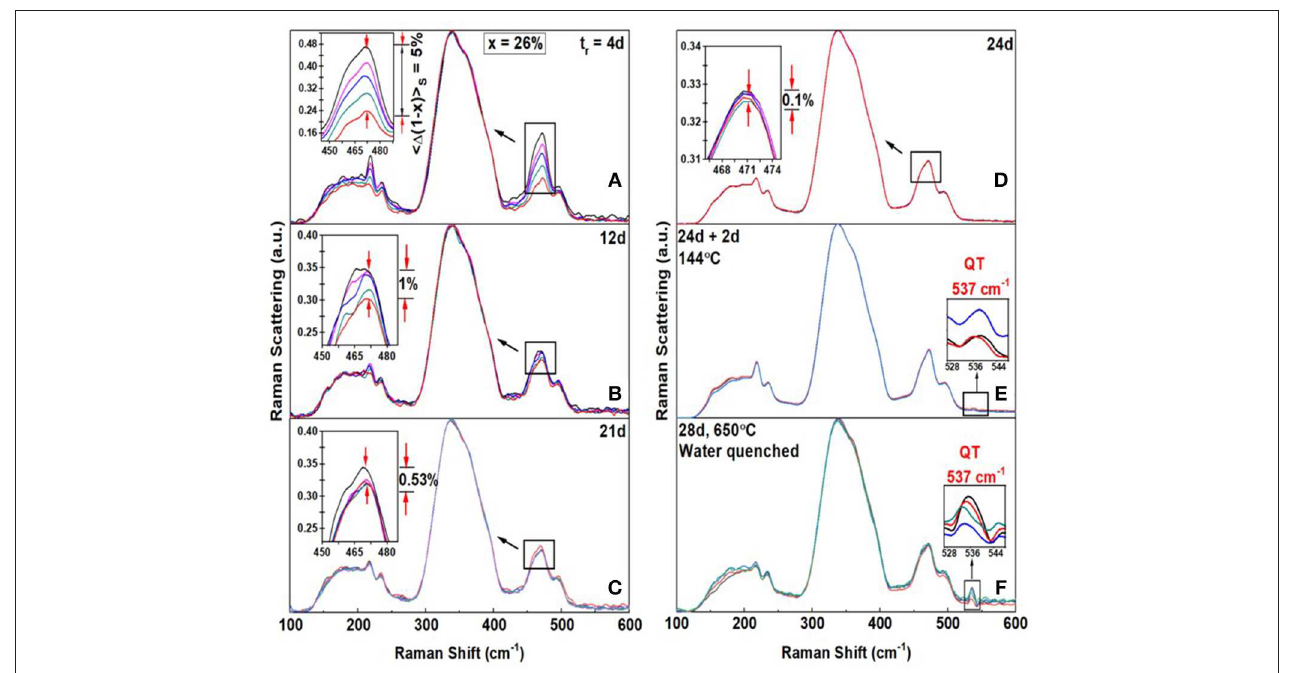
FIGURE 7 | FT—Raman profiling results of an As x S 100 − x glass at x = 26% revealing the Sulfur variance <1 (1-x) > S (A) to be 5% after alloying for t r = 4d (B) the variance ∼ 1% after t r = 12d, (C) the variance = 0.53% after 12d (D) the variance = 0.1% after t r = 24d. (E) When the glass is heated to 144 ◦ C = T g + 10 ◦ C for 2d, evidence of the 537 cm − 1 mode first appears. (F) When glass was next heated to 650 ◦ C for 2d and water quenched, the scattering strength of the 537 cm − 1 mode increased substantially. These changes in Raman lineshapes in going from step (E) to (F) , closely mimic those seen at x = 18% in Figure 4 . In particular note that the 217 cm − 1 mode of S 8 rings decreases in scattering strength in going from (E) to (F) . These changes in Raman scattering at x = 18% and at x = 26%, particularly the growth of the 537 cm − 1 upon T g cycling the glass followed by a heating step to 650 ◦ C and a water quench, reinforce the schematic structural changes suggested in the model of Figure 5